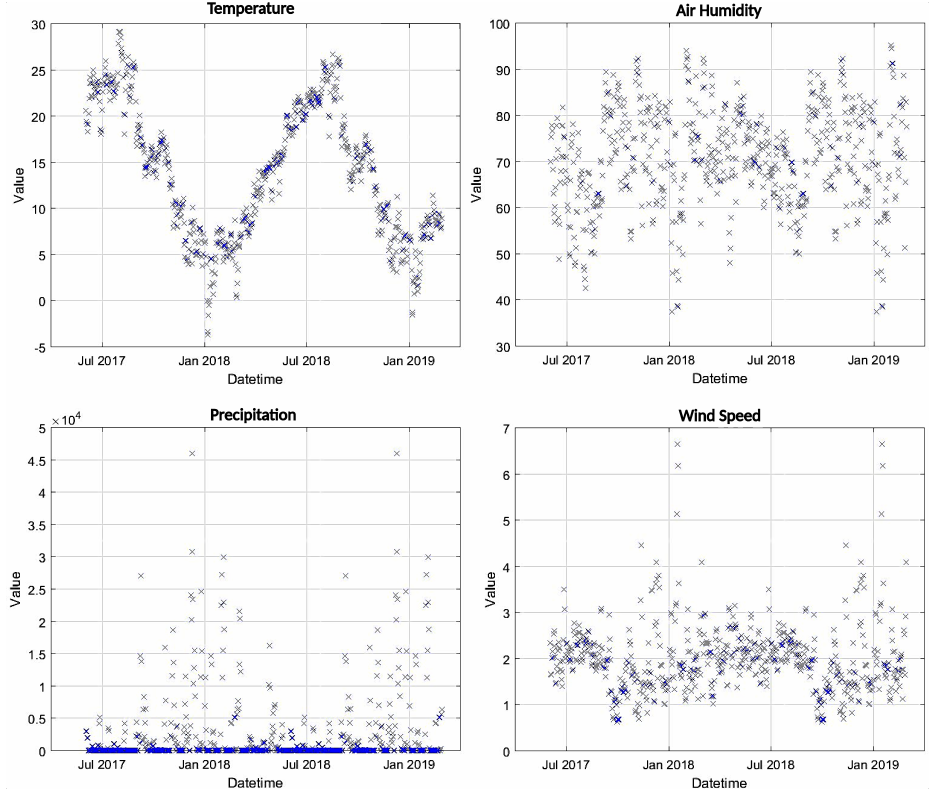
Figure 9. Daily values of the weather variables after averaging the Kriging interpolation over the area of interest.